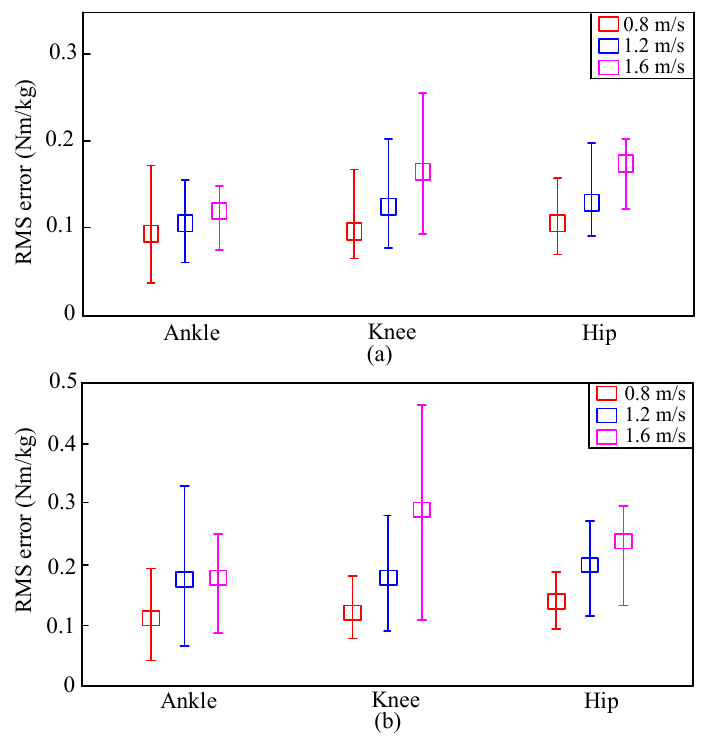
Figure 7. RMS errors of ( a ) proposed DGP and ( b ) GP models.